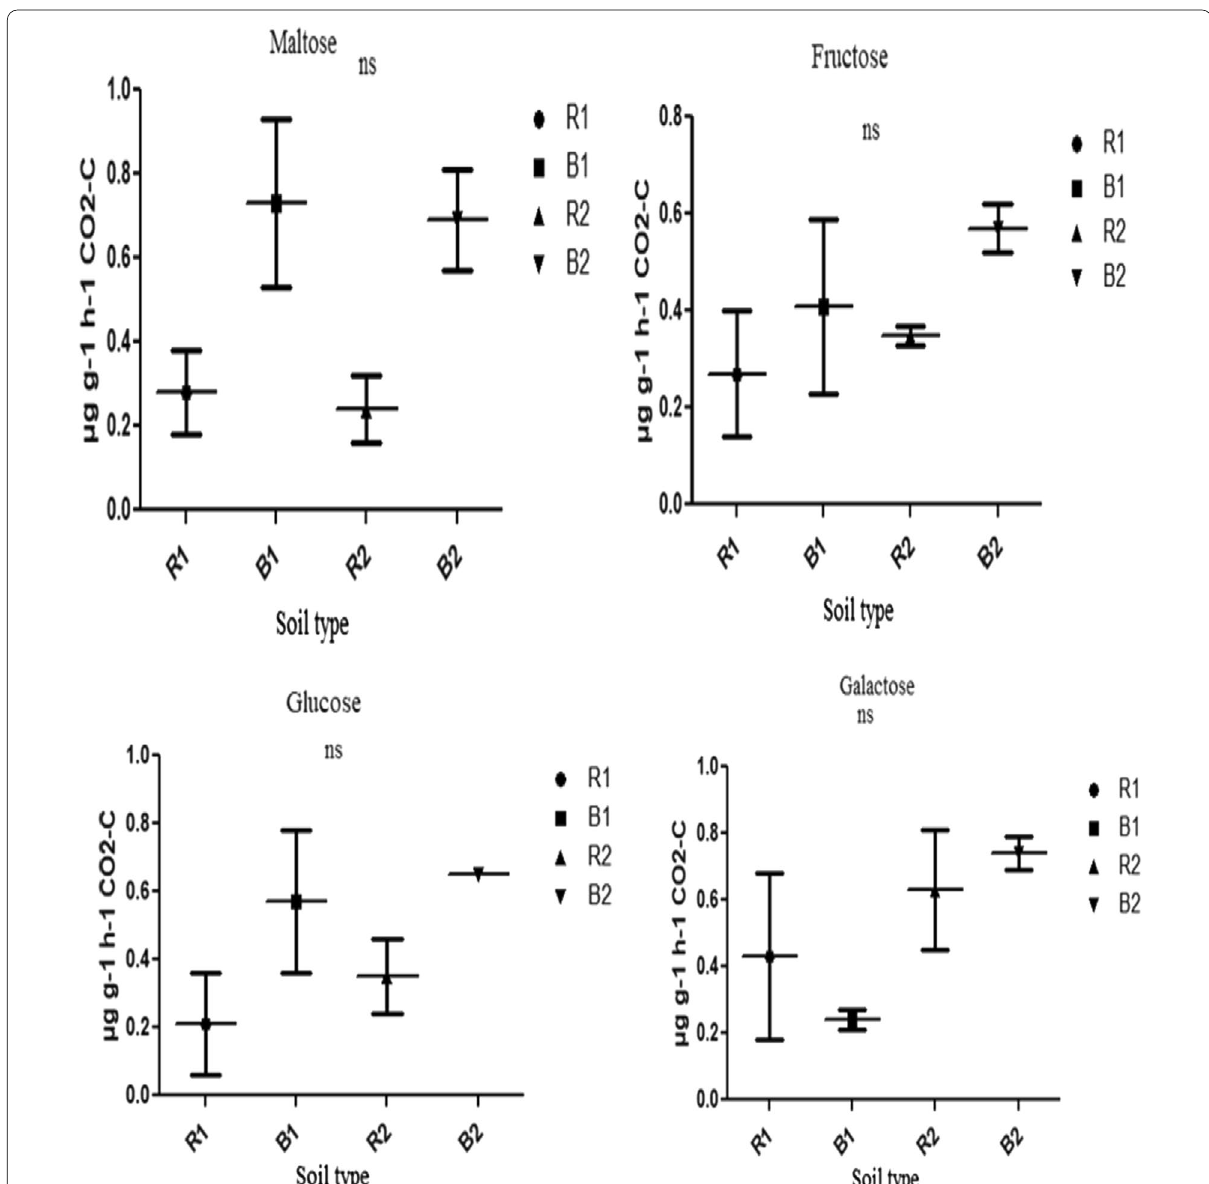
Fig. 8 Effects of soil type on soil functional properties as measured for maltose, fructose, glucose and galactose using MicroResp assay. Number of replicates (n) 2. Data represent mean SE, ns not statistically significant; R1 Ditsobottla rhizosphere soil; B1 Ditsobottla bulk soil; R2 Kraaipan = ± rhizosphere soil; B2 Kraaipan bulk